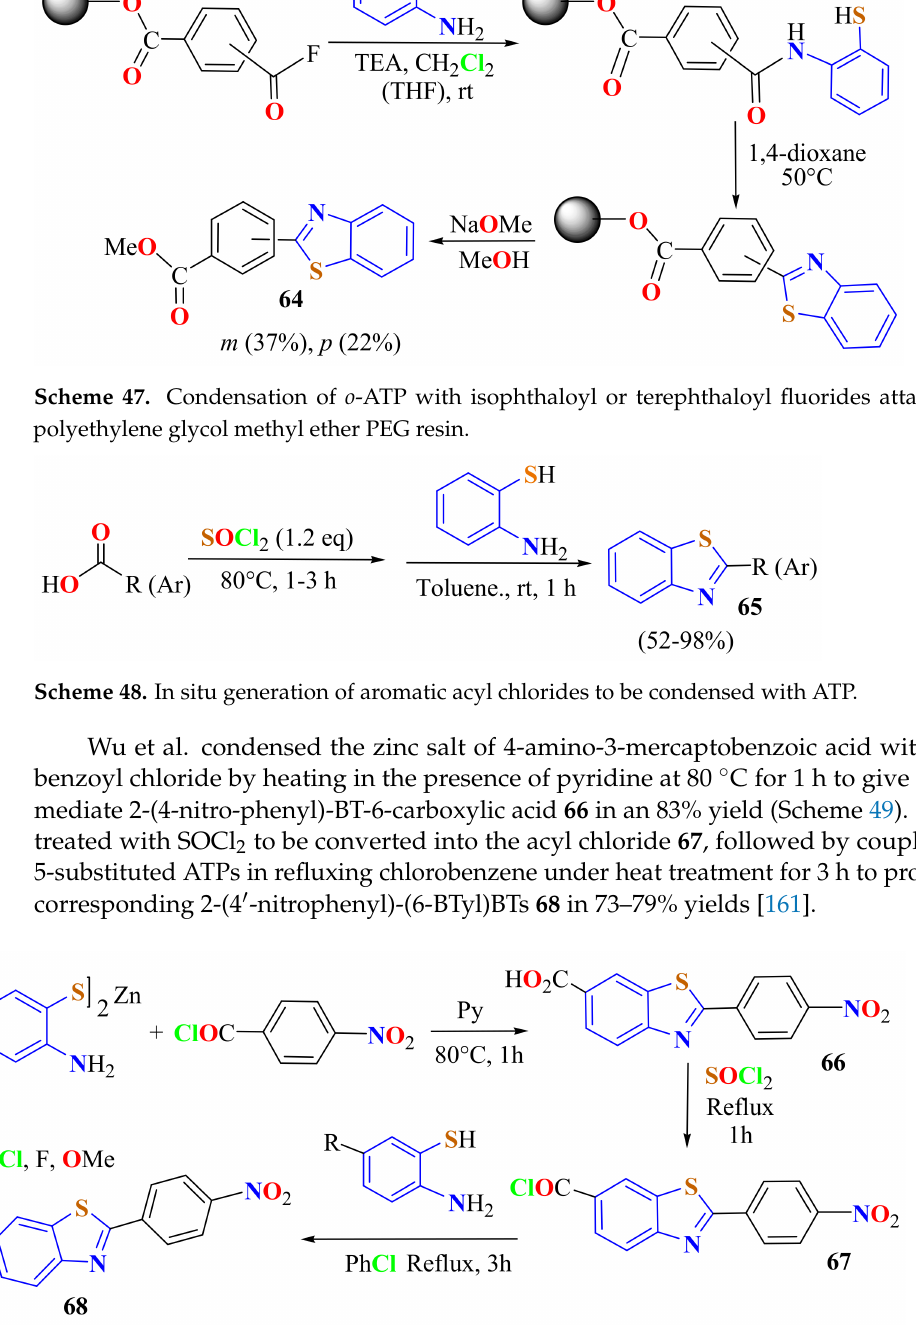
Scheme 49. Double condensation of substituted ATP derivatives with acid